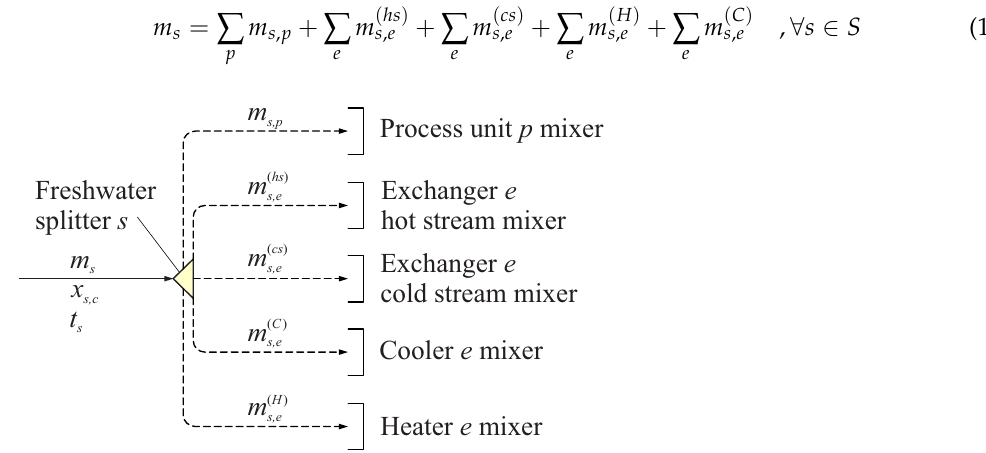
Figure 5. Freshwater splitter with corresponding streams.